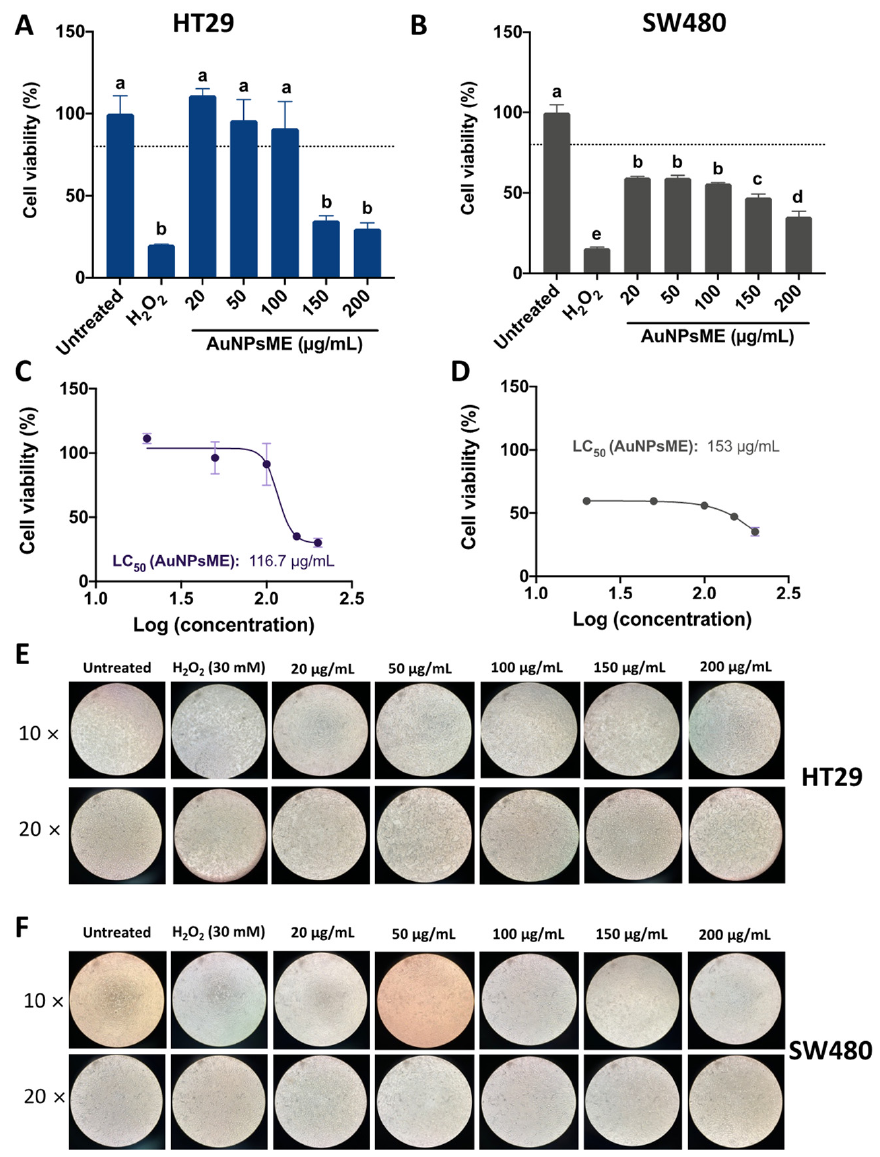
Figure 4. Assessment of HT29 and SW480 cell viability after treatment with common mullein ( V. thapsus ) flowers ethanolic extracts-gold nanoparticles (AuNPsME) treatments. ( A ) Evaluation of the impact of AuNPsME (20–200 µg/mL) and controls (untreated cells, 30 mM H 2 O 2 ) in HT29 cells viability; ( B ) Effect of AuNPsME in SW480 cells viability; ( C ) Calculated IC 50 of AuNPsME treatments on HT29 cells; ( D ) Calculated IC 50 of AuNPsME treatments on SW480 cells; ( E ) Representative pictures (10 × and 20 × ) of AuNPsME effects on HT29 cells; ( F ) Representative pictures (10 × and 20 × ) of AuNPsME effects on SW480 cells. Hydrogen peroxide (H 2 O 2 )-treated cells (30 mM) were used